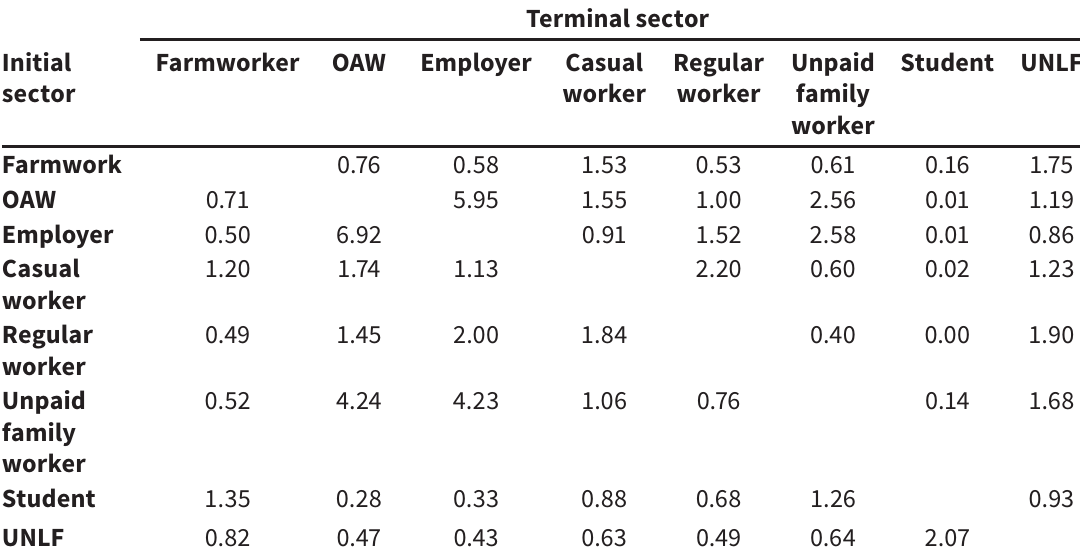
Transition probabilities ( T -matrix)